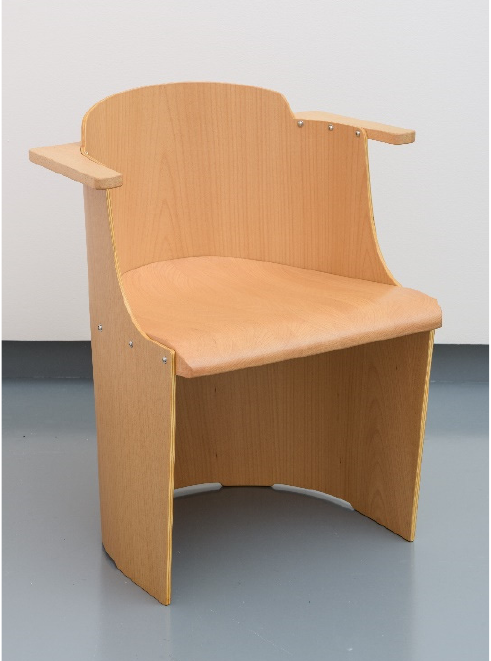
Figure 27. El Lissitzky, ‘Armchair of bent plywood’, 1930, reconstruction by Mark van den Heuvel, 2012. Van Abbemuseum. Photo: Peter Cox.